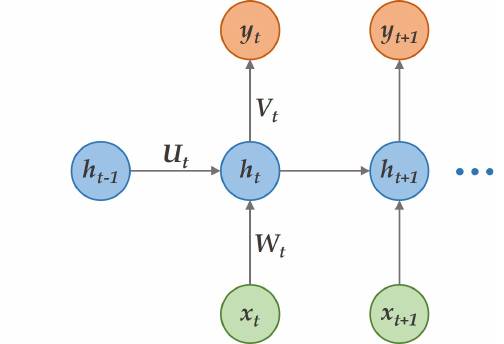
Figure 8. A standard RNN architecture. The feedback loop provided by the previous output U t gives memory capabilities to these